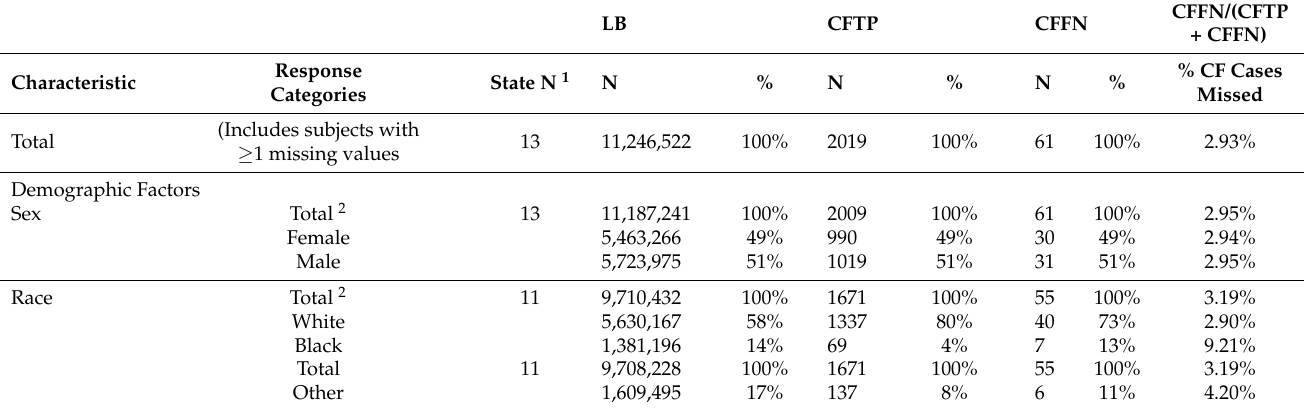
Table 2. Distribution of study factors by number of states in the analysis, study groups, and percent- age of cystic fibrosis cases missed due to IRT being below program